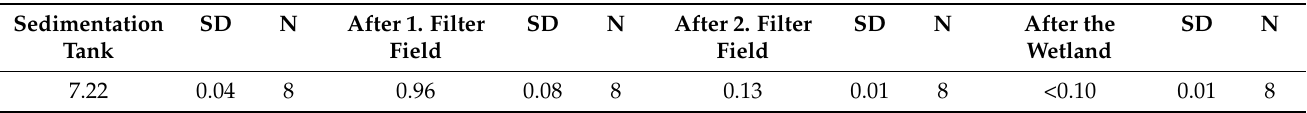
Table 3. Average concentration of the surfactants (mg/L) with standard deviation (SD) in the waste water samples from the WWTP ECOver.